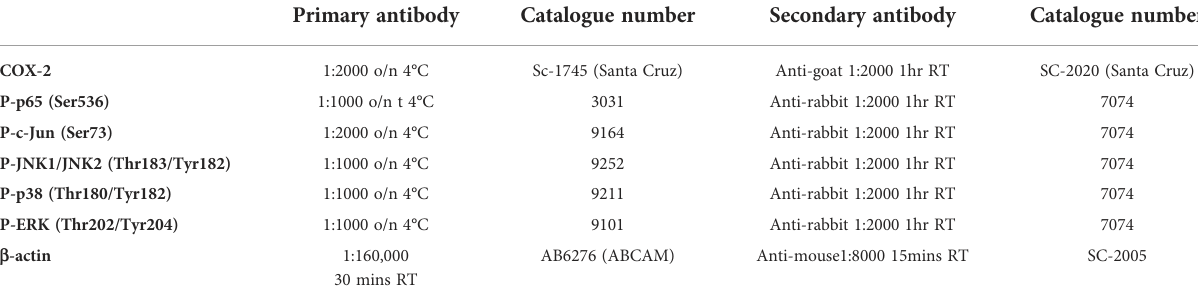
TABLE 1 Western immunoblotting